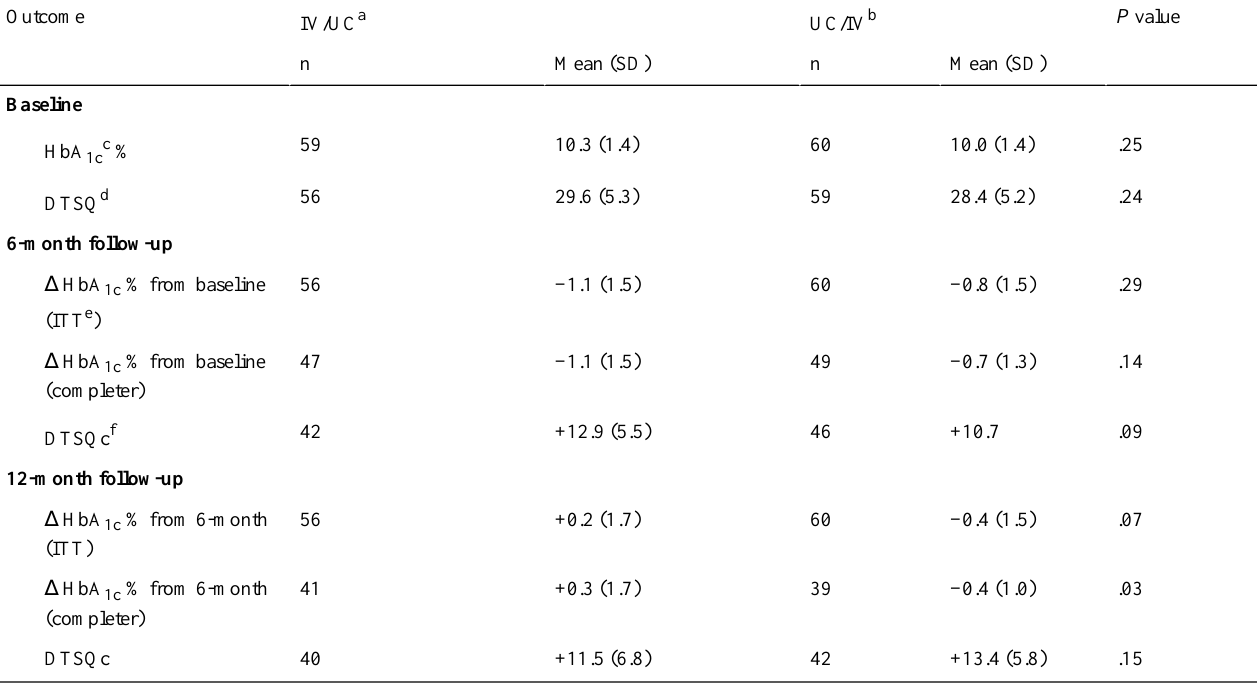
Table 2. Change in HbA 1c percentage and diabetes treatment satisfaction, by